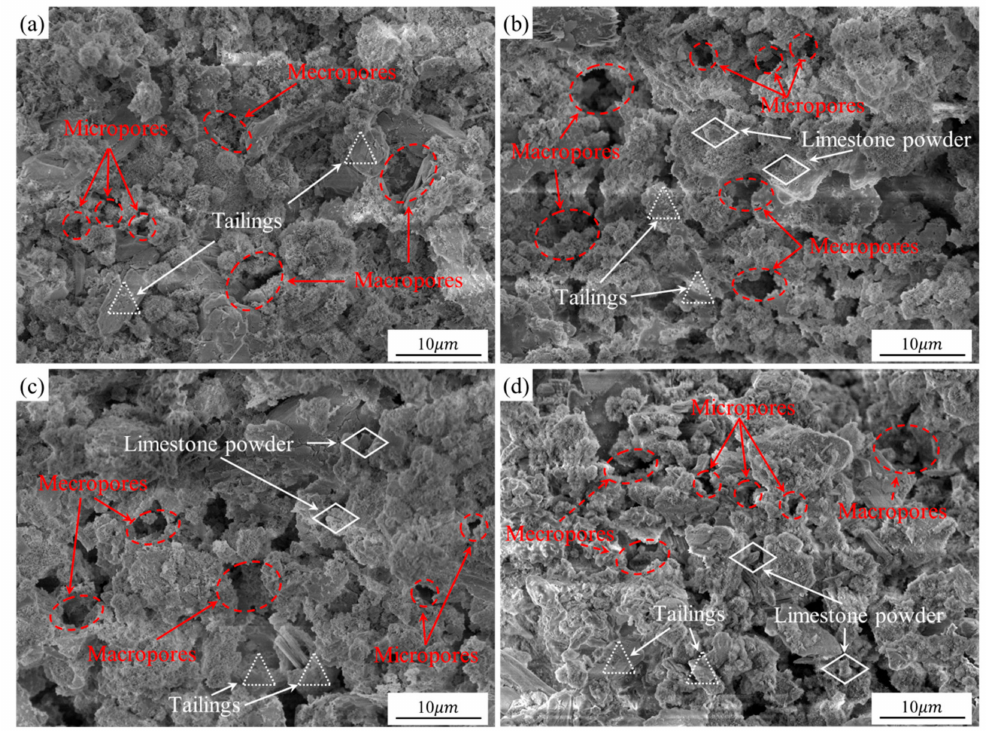
Figure 6. SEM images (5000 × ) of ( a ) A1, ( b ) A2, ( c ) A3, and ( d ) A4.